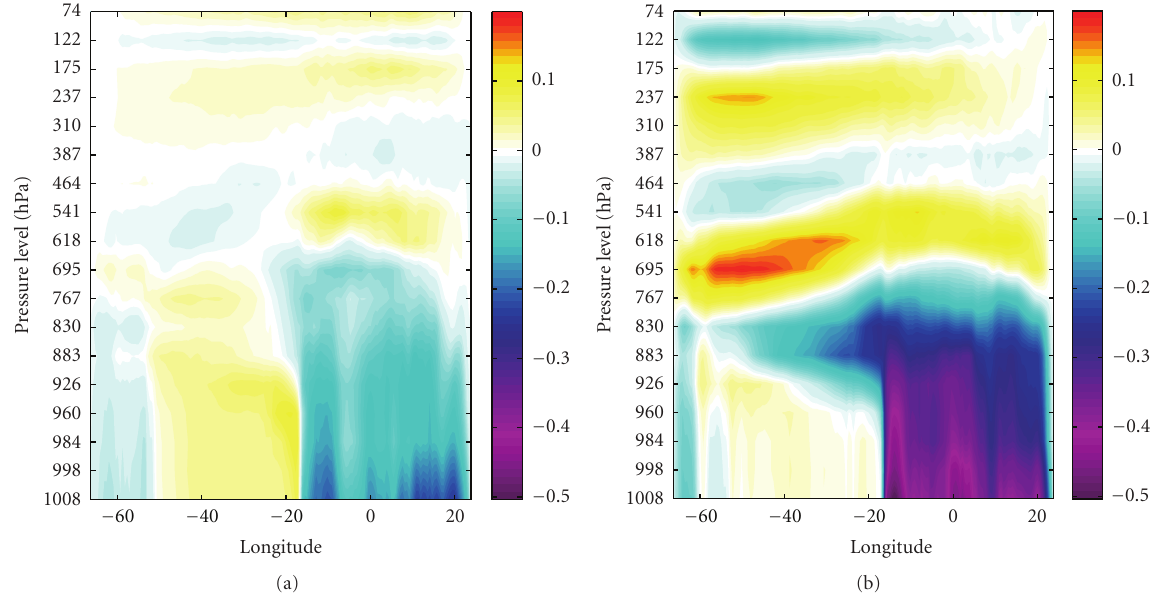
Figure 13: Zonal vertical profile of dust e ff ect on temperatures in ◦ C, averaged between 0 ◦ N and 25 ◦ N during the periods (a) MAM and (b) JJA. Cooling is indicated with cool colors while warming with hot